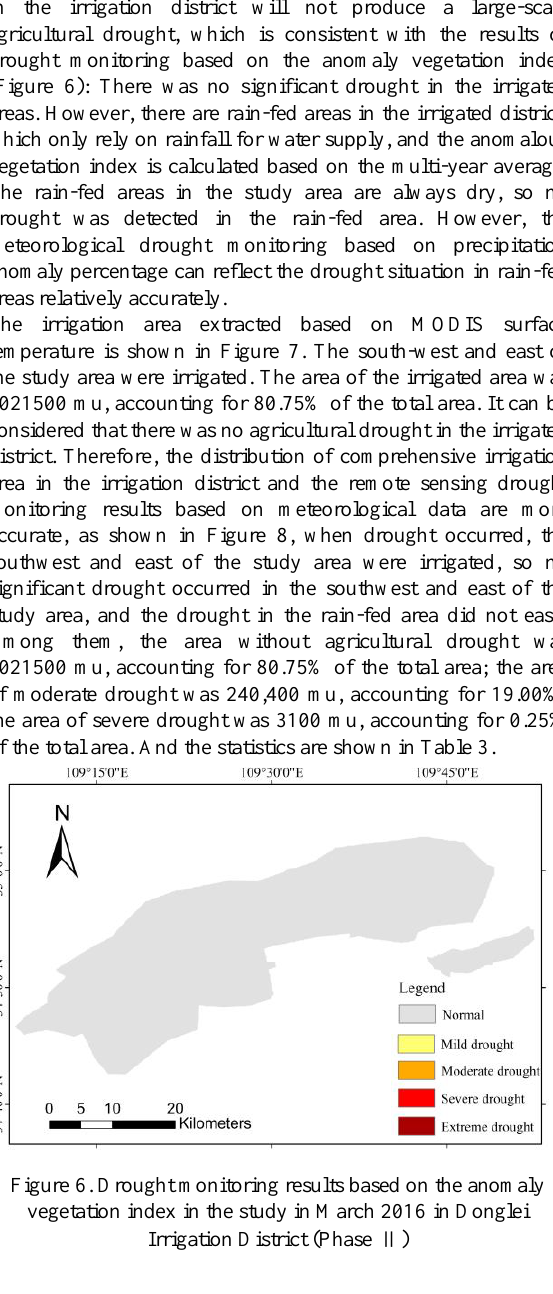
Figure 7. Monitoring results of irrigated area based on surface temperature in the study area in March 2016 in Donglei Irrigation District (Phase Ⅱ )